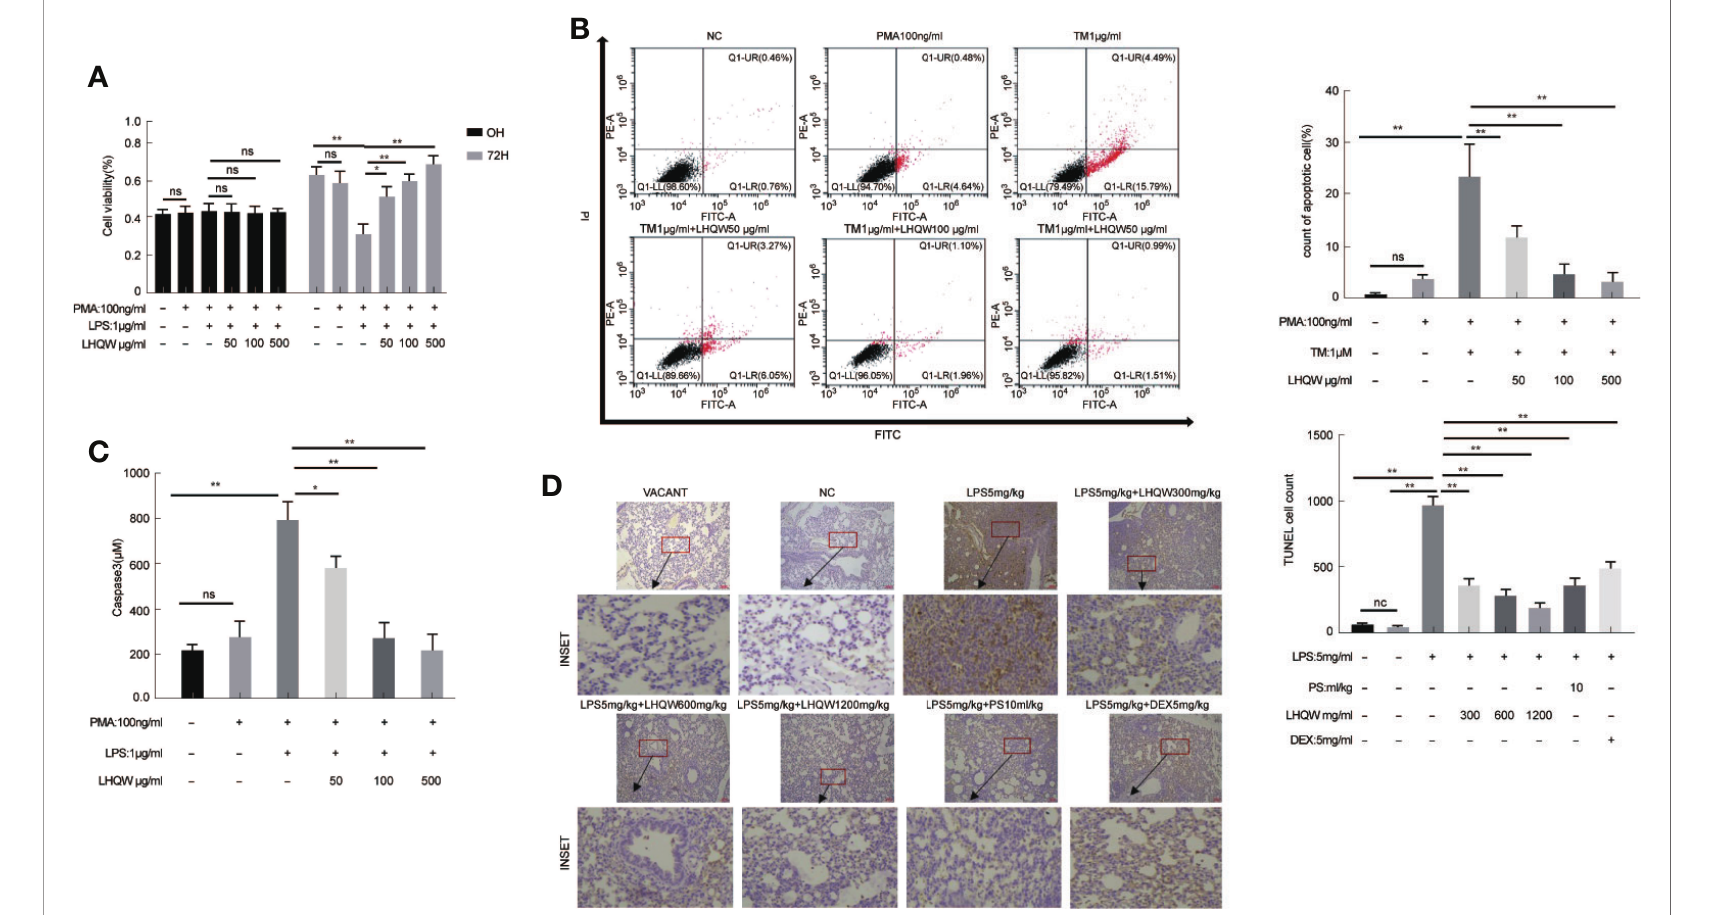
FIGURE 4 | Lian Hua Qing Wen capsule (LHQW) protected alveolar epithelial cells against TRAIL-induced apoptosis. Lung tissue come from ALI model mice were fi xed in 4% PFA, then 3-5- m m sections were prepared after paraf fi n embedding. All sections were subjected to immunohistochemistry. In the macrophage-epithelial co-cultural model, human pulmonary alveolar epithelial cells (HPA cells) in 6-well plates were incubated with supernatant from THP1 cells that were treated with LHQW, tunicamycin (TM), and lipopolysaccharide (LPS). (A) The effect of LHQW on increasing the cell counting of HPA cells in the macrophage- epithelial co-cultural model, which was based on MTT assays. (B, C) LHQW alleviated apoptosis in the macrophage-epithelial co-cultural model measured by (B) AV-PI assay and (C) caspase3 activity. (D) The number of apoptotic cells (dark brown) in lung tissue measured by TUNEL (200×). THP1 cells in 6-well plates were fi rst treated with PMA for 24 h, followed by LHQW and LPS for another 24 h, then the supernatant was collected. The data was presented as the mean ± S.E.M. of three independent experiments. # P < 0.05 vs. the NC group. * P < 0.05, ** P < 0.01 vs. the LPS group. LHQW-L: 50 m g/ml; LHQW-M: 100 m g/ml; LHQW-H: 500 m g/ml; TM: